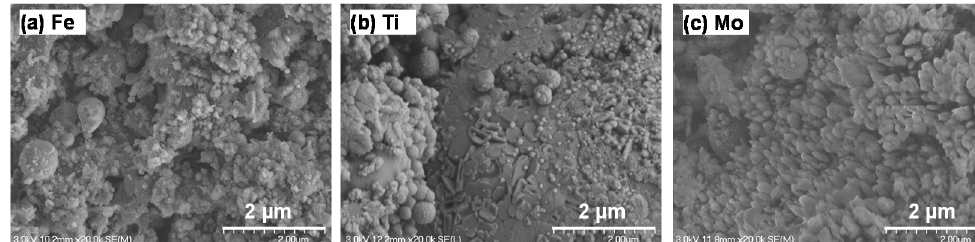
Figure 14. XRD patterns of coatings produced from Al and melamine on different substrates.